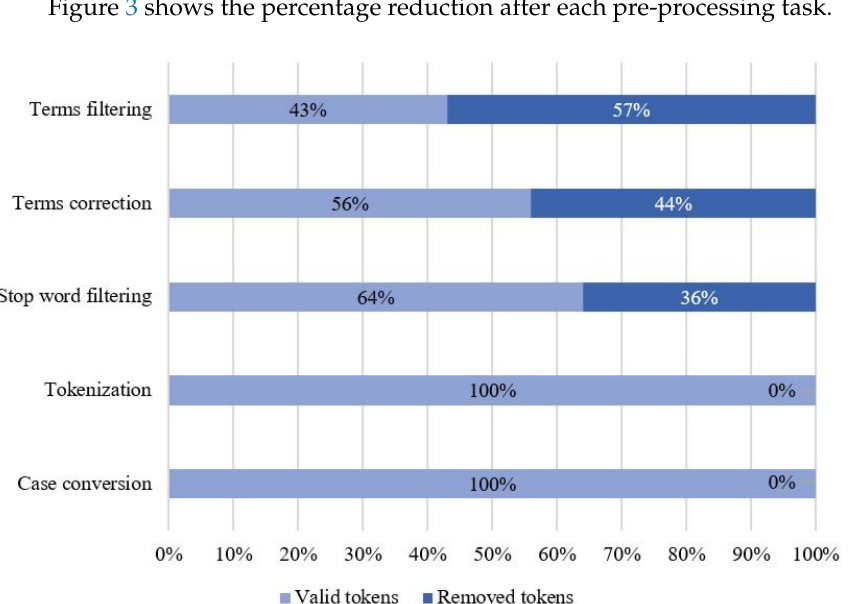
Figure 3. Valid tokens proportion after pre-processing.